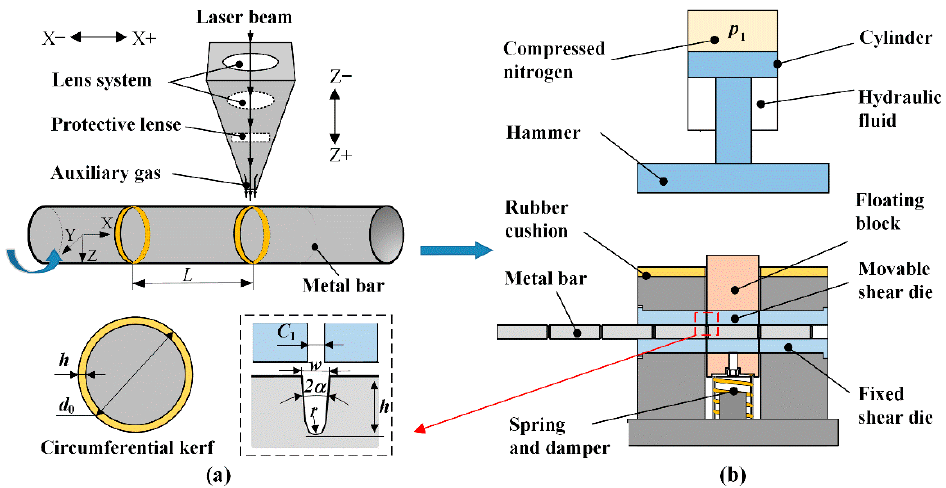
Figure 2. Schematic of the LAHSS method. ( a ) Stage one: fabricate circumferential kerfs by laser. ( b ) Stage two: high-speed shearing of radially constraint metal bar on a power-drop hammer.